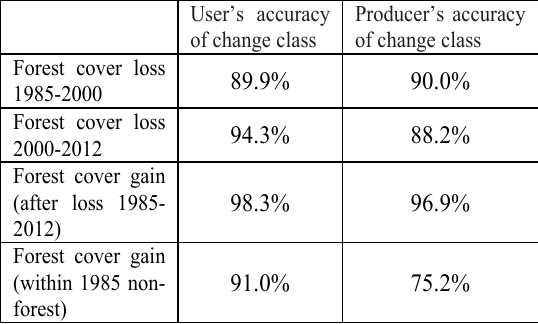
Table 1. Accuracy measurements for the regional forest cover change products